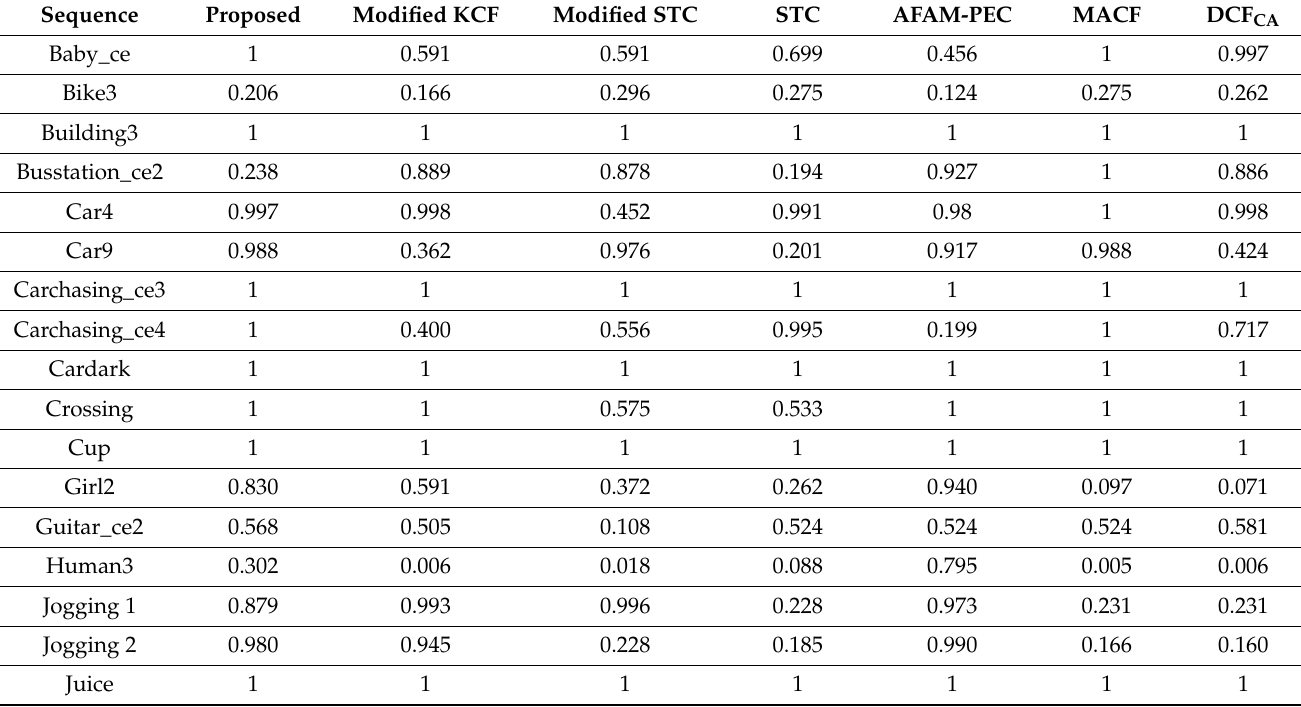
Table 2. Distance precision rate at the threshold of 20